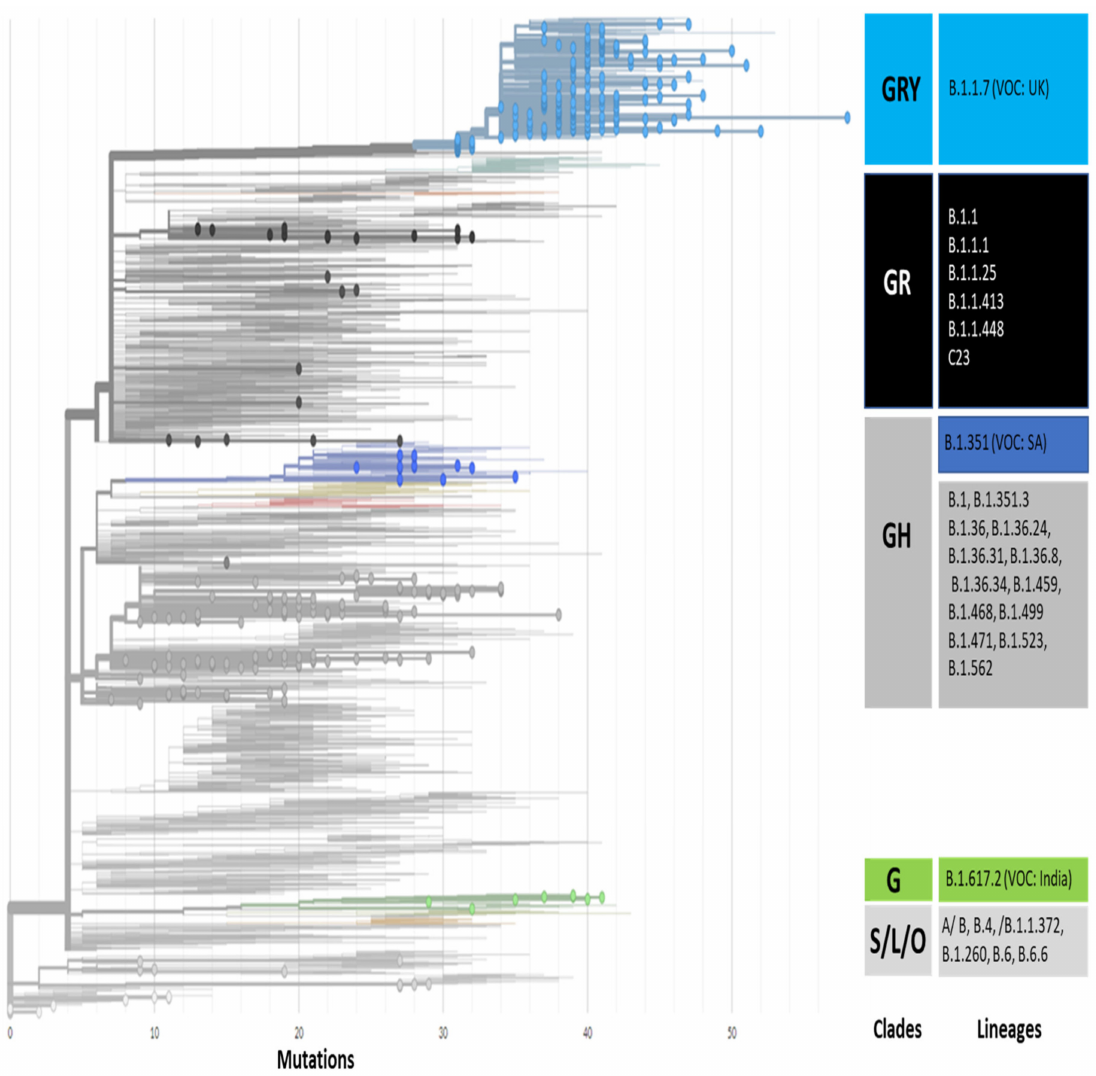
Figure 7. Maximum likelihood phylogenetic tree of Pakistani samples showing 7 clades and 29 lineages. The global SARS-CoV-2 genomes depicting the highest mutations ranging from 30 to 50 in Pakistani samples under the lineage of B.1.1.7, also known as UK variants of concern (UK-VOC). The light blue, dark blue, black, green, light & dark gray dots in the phylogenetic tree show the distribution of Pakistani SARS-CoV-2 samples in the respective